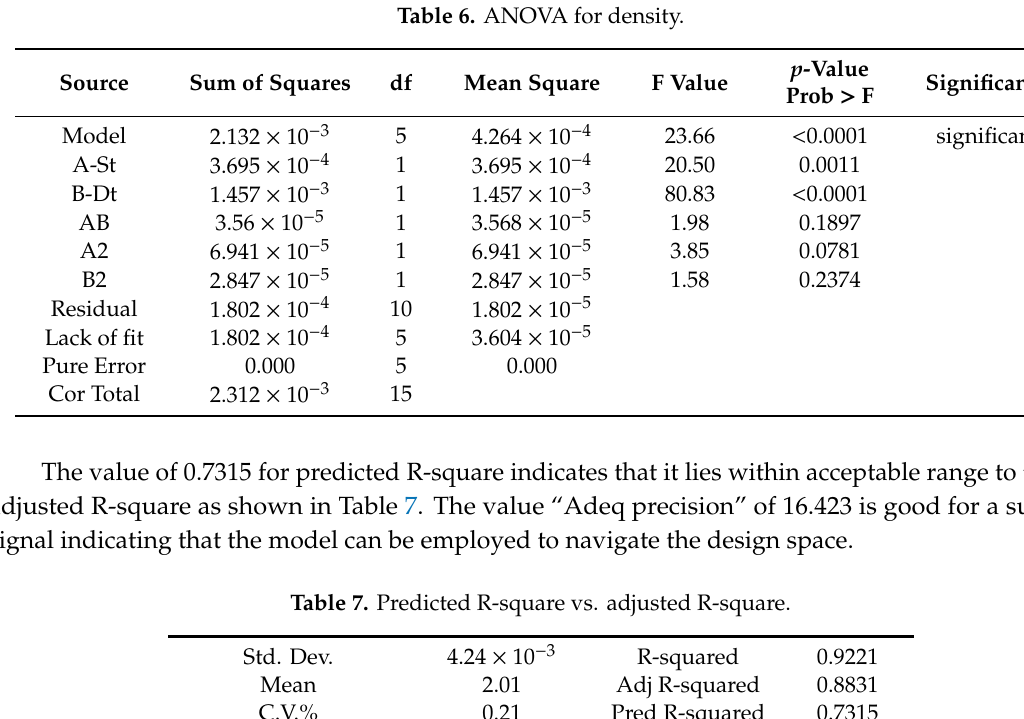
Table 6. ANOVA for density.